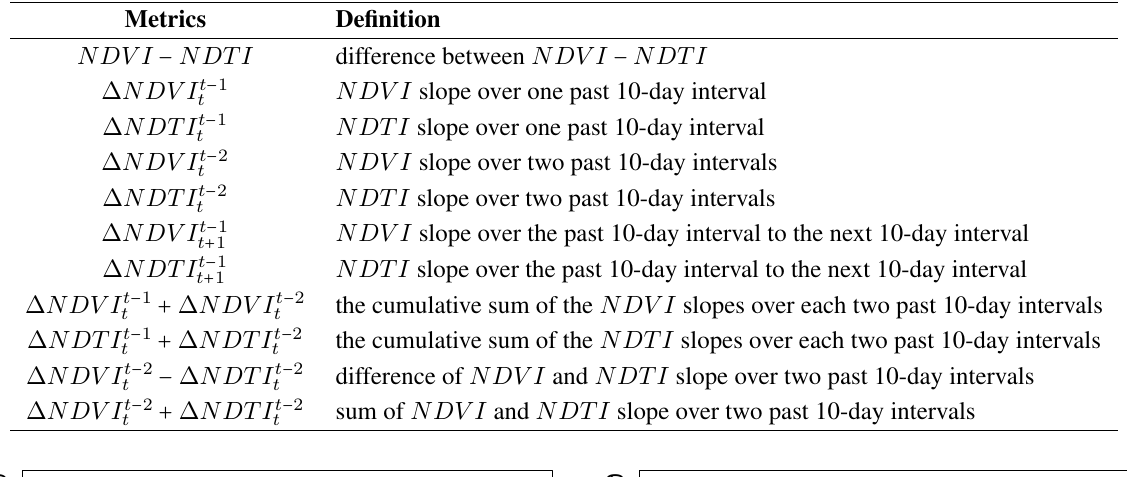
Table 2. Definition of the metrics tested.